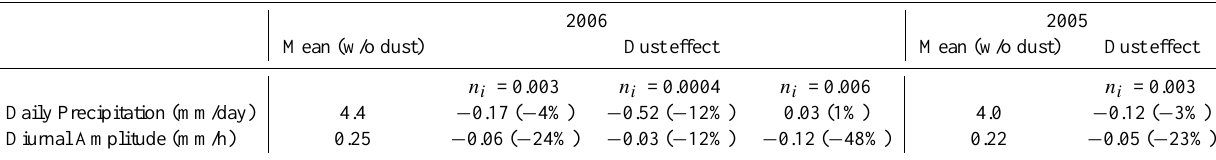
Table 2. WRF-Chem simulated mean dust effect on the daily precipitation and diurnal amplitude of precipitation over the WAM region (6 ◦ N– 17 ◦ N and 15 ◦ W–10 ◦ E) during the wet monsoon season (May–September). The column “Mean (w/o dust)” shows the daily precipitation and diurnal amplitude of precipitation from WRF-Chem simulation without dust. “ n i ” represents the imaginary part of SW refractive index of